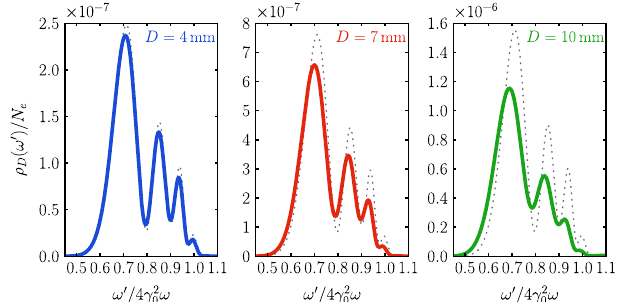
FIG. 5. Photon spectrum for a finite detector size. The solid curves correspond to a detector geometry as described below Eq. (33) with diameter D ¼ 4 mm (left panel), 7 mm (center panel), and 10 mm (right panel) at a distance of L ¼ 1 m from the interaction point in the mean direction of the primary electron beam for an electron incidence angle (cid:6) 0 ¼ 10 (cid:9) . For comparison, the spectra of an idealized pointlike detector (cid:10) normalized to the same effective size are also plotted as dotted lines in each